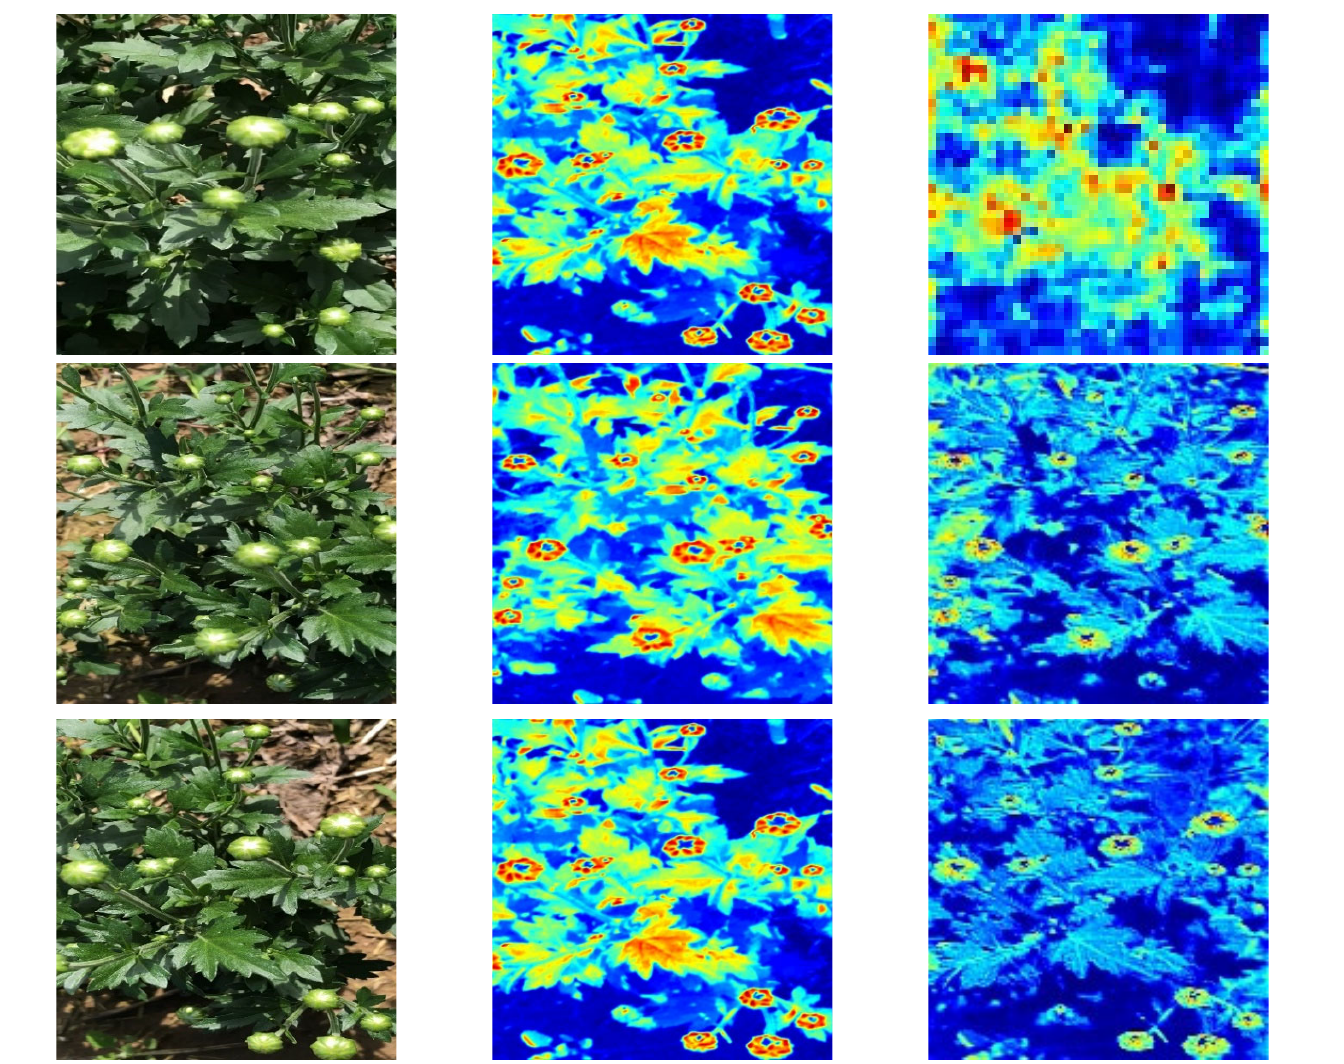
Figure 5. Visualization results of some input